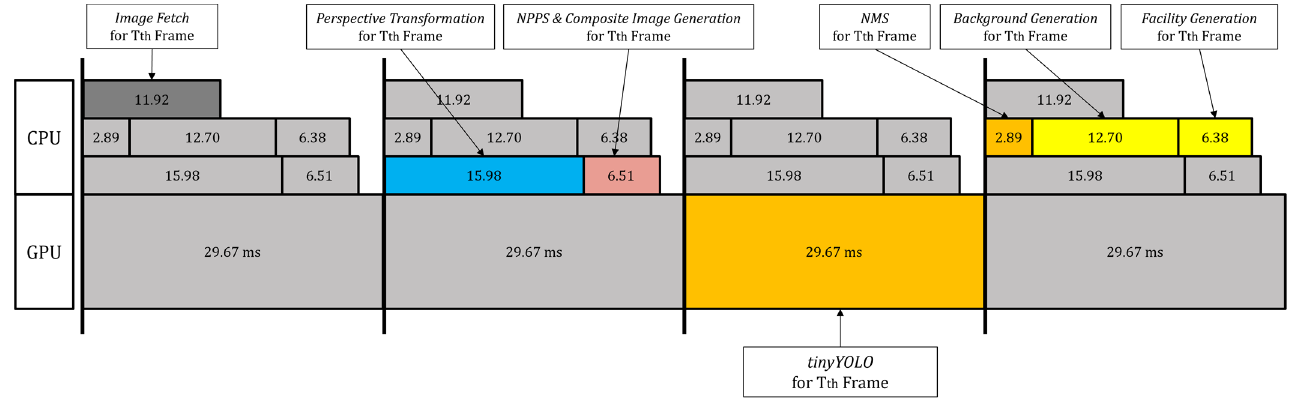
Figure 16. Illustration of the code structure for a pipelined execution, along with execution times